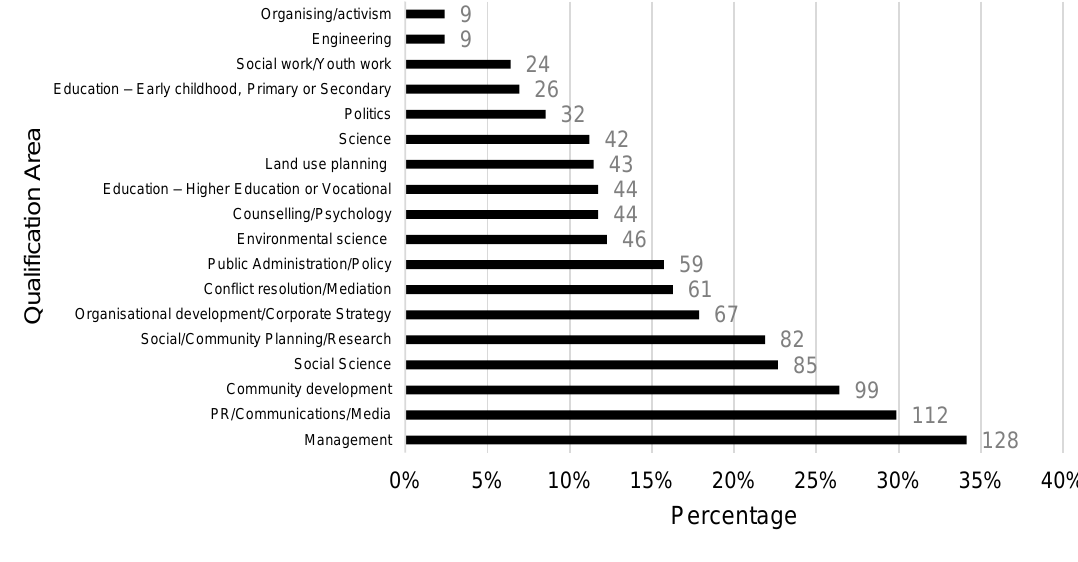
Figure 9. Areas of qualification of participatory and deliberative practitioners